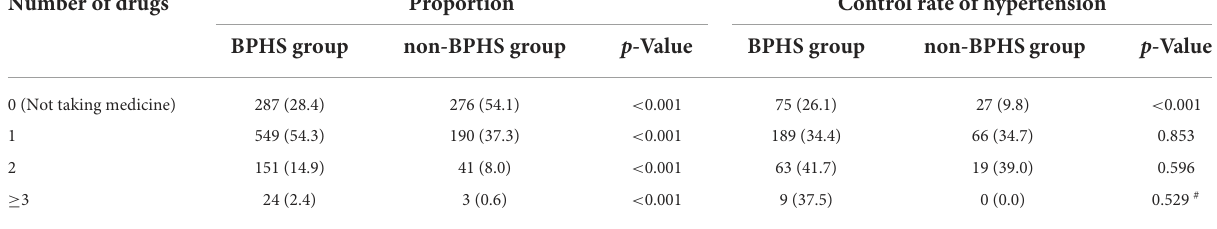
TABLE 4 Number of antihypertensive medications used and hypertension control rate between the BPHS and non-BPHS